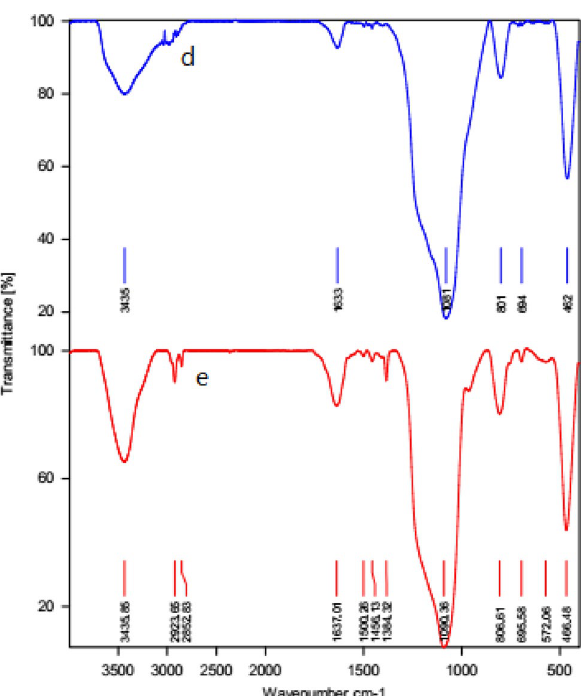
Figure 27. The FT-IR spectrum of HMS/Pr-PTSC-Cu (d) and recovered HMS/Pr-PTSC-Cu